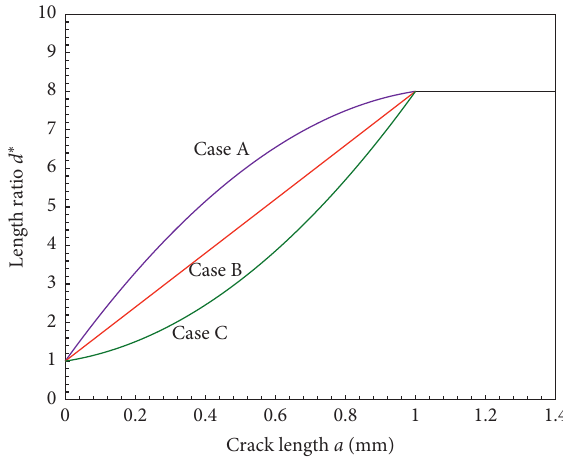
Figure 11: Variation of length ratio d ∗ with crack length a. Table 2: Values of two parameters C and m in the EDZ model.